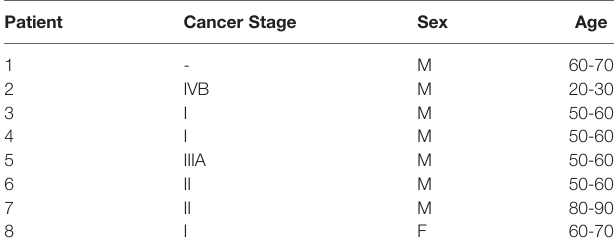
TABLE 1 | Primary hepatocellular carcinoma patient characteristics. Patient Cancer